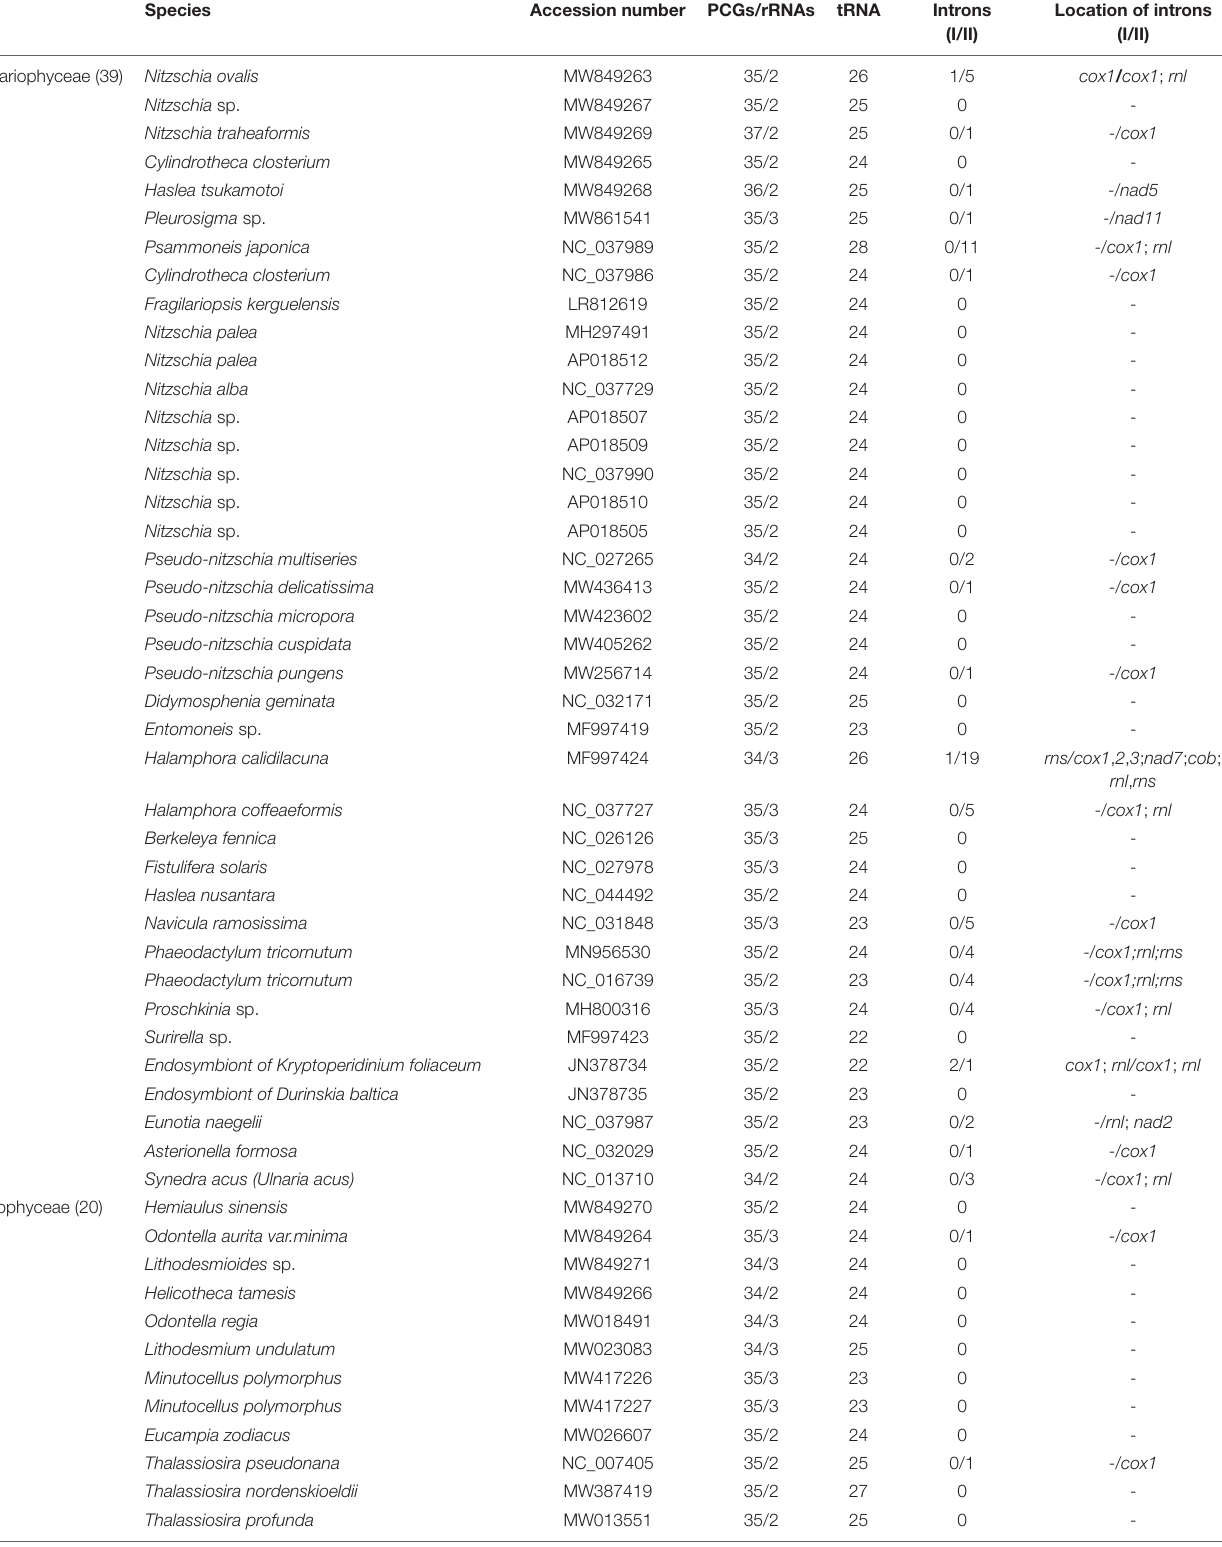
TABLE 3 | Mitochondrial gene content of 68 mtDNAs from the Phylum Bacillariophyta. Species Accession number PCGs/rRNAs